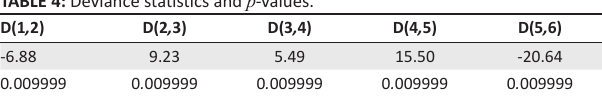
TABLE 4: Deviance statistics and p -values.